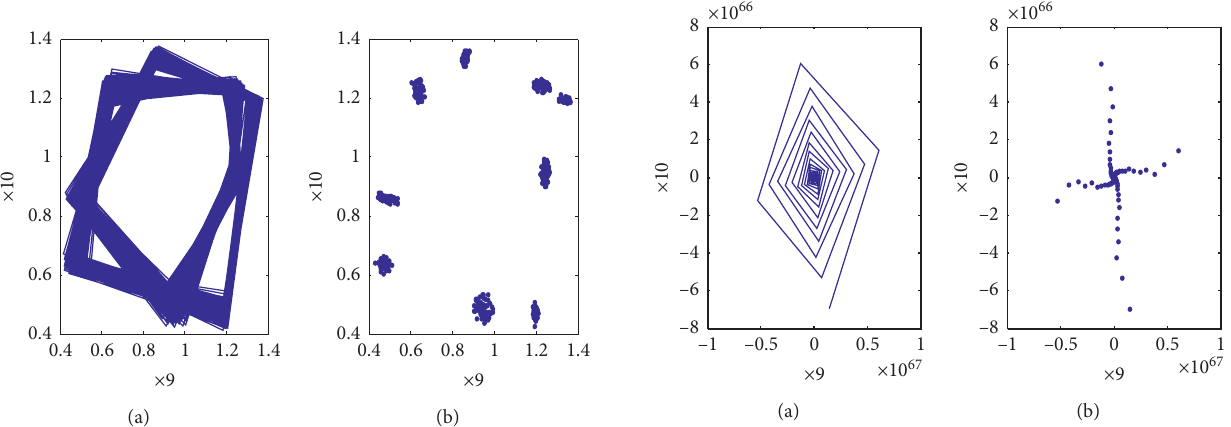
Figure 44: ω � 285 with random Perturbation.